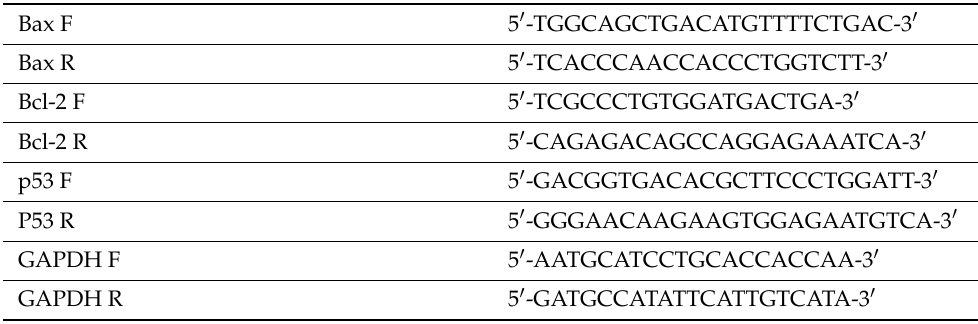
Table 4. Sequences of the primers used in real-time polymerase chain reaction